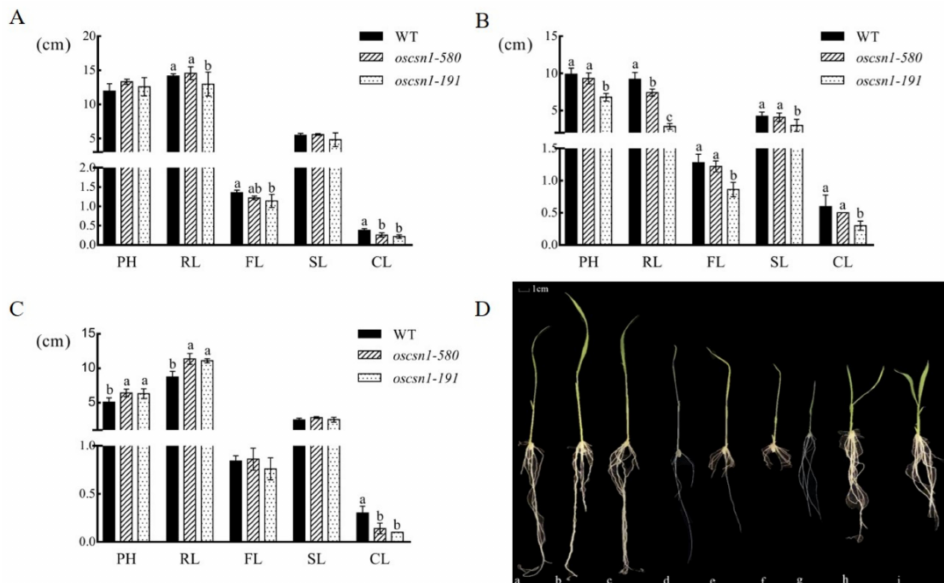
Figure 4. Phenotypic analysis of 10-day-old wild type and oscsn1 mutants grown under different conditions. ( A ) Phenotypic analysis of plants under red light. PH, plant height; CL, coleoptile length; RL, radicle length; FL, the first leaf length; SL, the second leaf length. The small letters a, b represent the within-group difference significance analysis. ( B ) Phenotypic analysis of plants under the far-red light. PH, plant height; CL, coleoptile length; RL, radicle length; FL, the first leaf length; SL, the second leaf length. The small letters a, b, c represent the within-group difference significance analysis. ( C ) Phenotypic analysis of plants under the blue light. PH, plant height; CL, coleoptile length; RL, radicle length; FL, the first leaf length; SL, the second leaf length. The small letters a, b represent the within-group difference significance analysis. Different letters within a column indicate significant differences at p < 0.05 according to Duncan’s multiple range test. ( D ) Image of 10-day-old wild type and oscsn1 mutant seedlings grown under different light conditions. Scale bar = 1 cm.